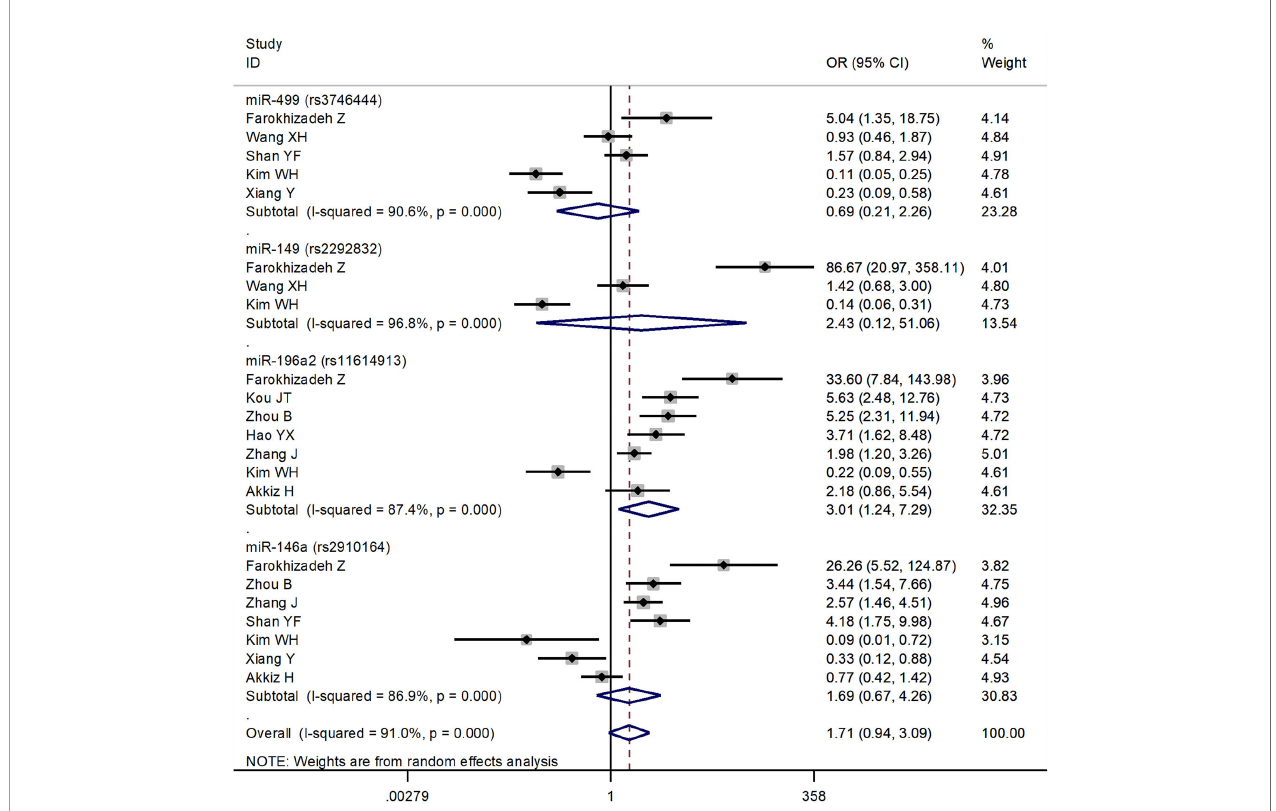
FIGURE 4 | Forest plots of the association of four single nucleotide polymorphisms (SNPs) under different hepatitis B virus (HBV) infection status in hepatocellular carcinoma (HCC) patients.